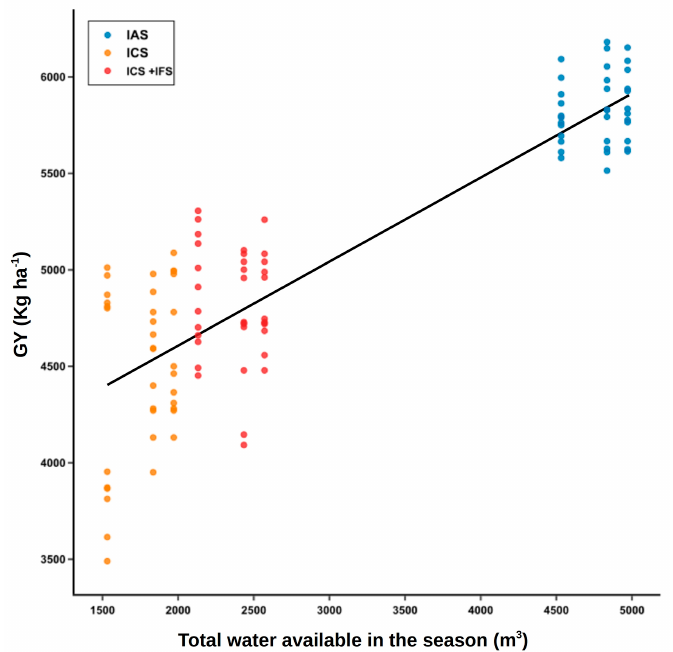
Figure 8. Regression of GY vs Water available to the crop. Table 2. Analysis of variance of residuals of regression between GY vs Water available to the crop as affected by treatments.